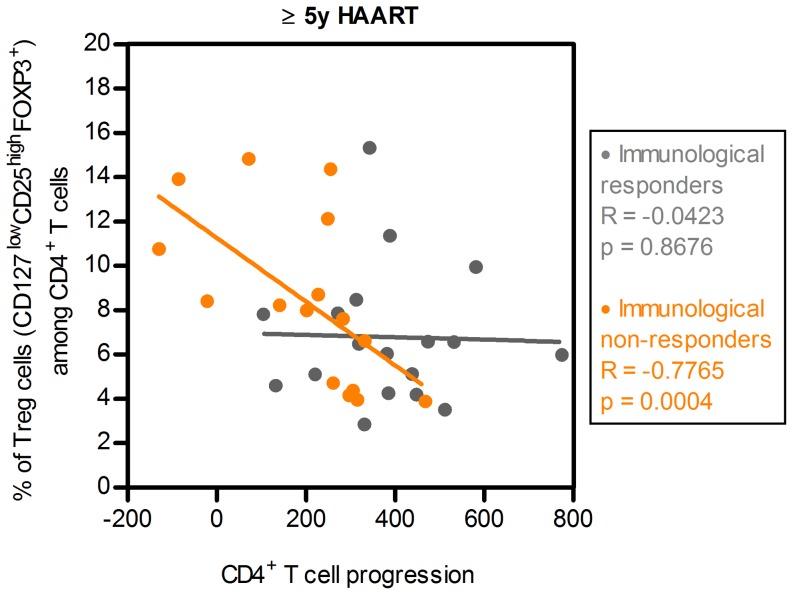
Immunological non-responders present a strong correlation between Tregs percentages and CD4+ T cell progression.Scatter plot illustrating the correlation between Tregs percentages and CD4+ T cell progression. Patients were selected on the basis of being under HAART for at least 5 years and whose actual CD4+ T cell counts are <500 cells/µL or >500 cells/µL. Each dot represents a single individual.